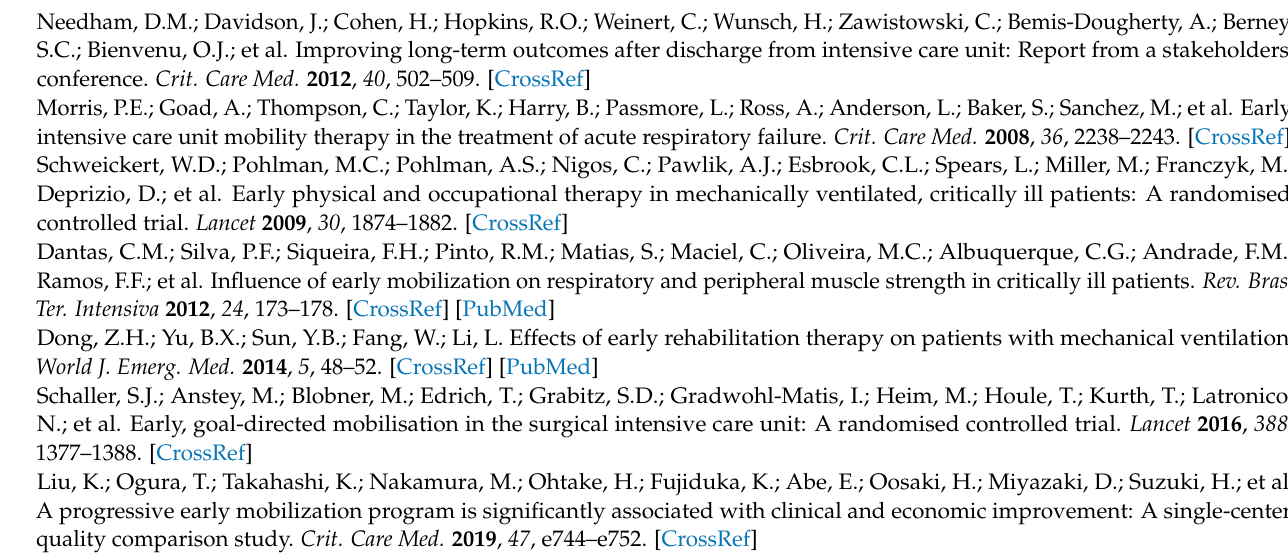
Table S2. Mobilization Protocol; Table S3. The Study Management